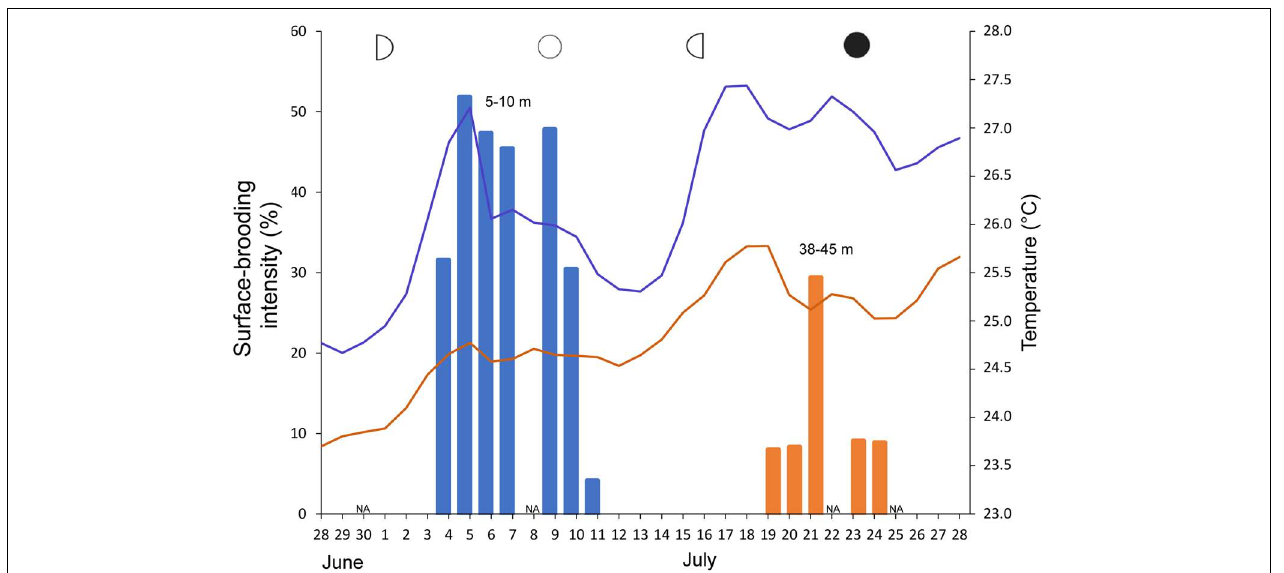
FIGURE 7 | Daily percentage of surface-brooded colonies of Rhytisma fulvum fulvum colonies in upper MCE (orange) and shallow reef (blue) during June–July 2017, with indication of lunar phase. Respective curves present daily mean temperature in both reef zones. NA represents days on which no dive was conducted.